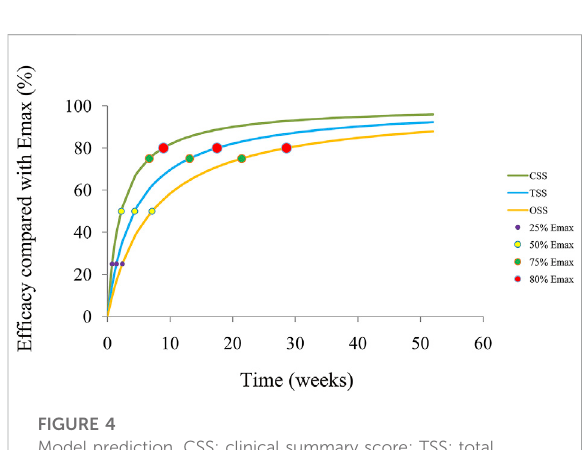
FIGURE 4 Model prediction. CSS: clinical summary score; TSS: total symptom score; OSS: overall summary